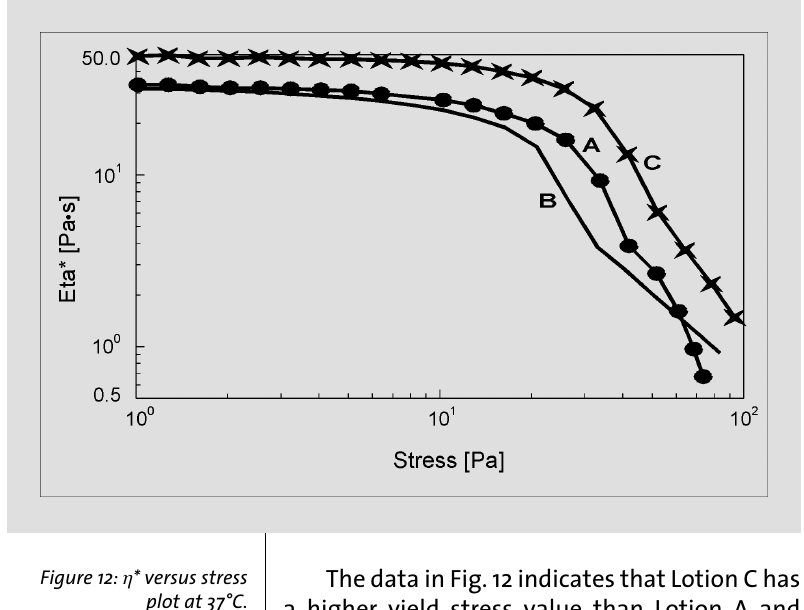
Figure 12: h * versus stress plot at